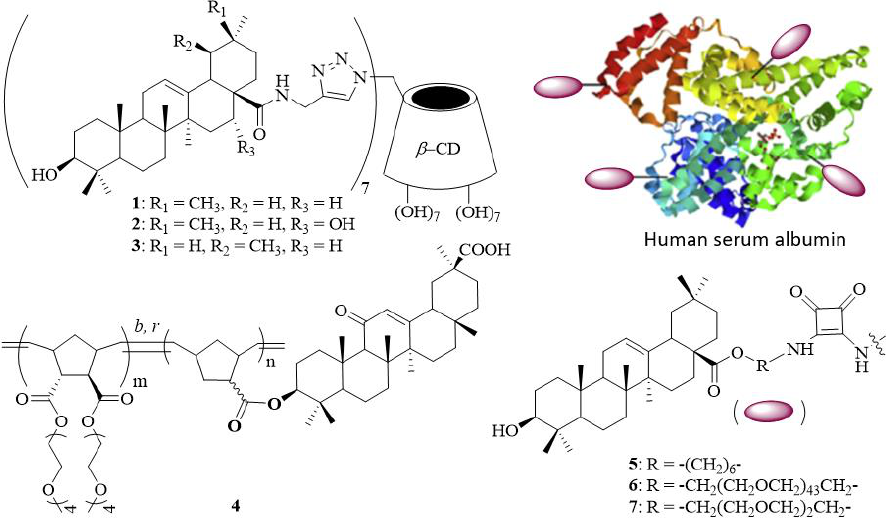
Figure 1. Structures of multivalent pentacyclic triterpene conjugates ( 1 – 7 ).